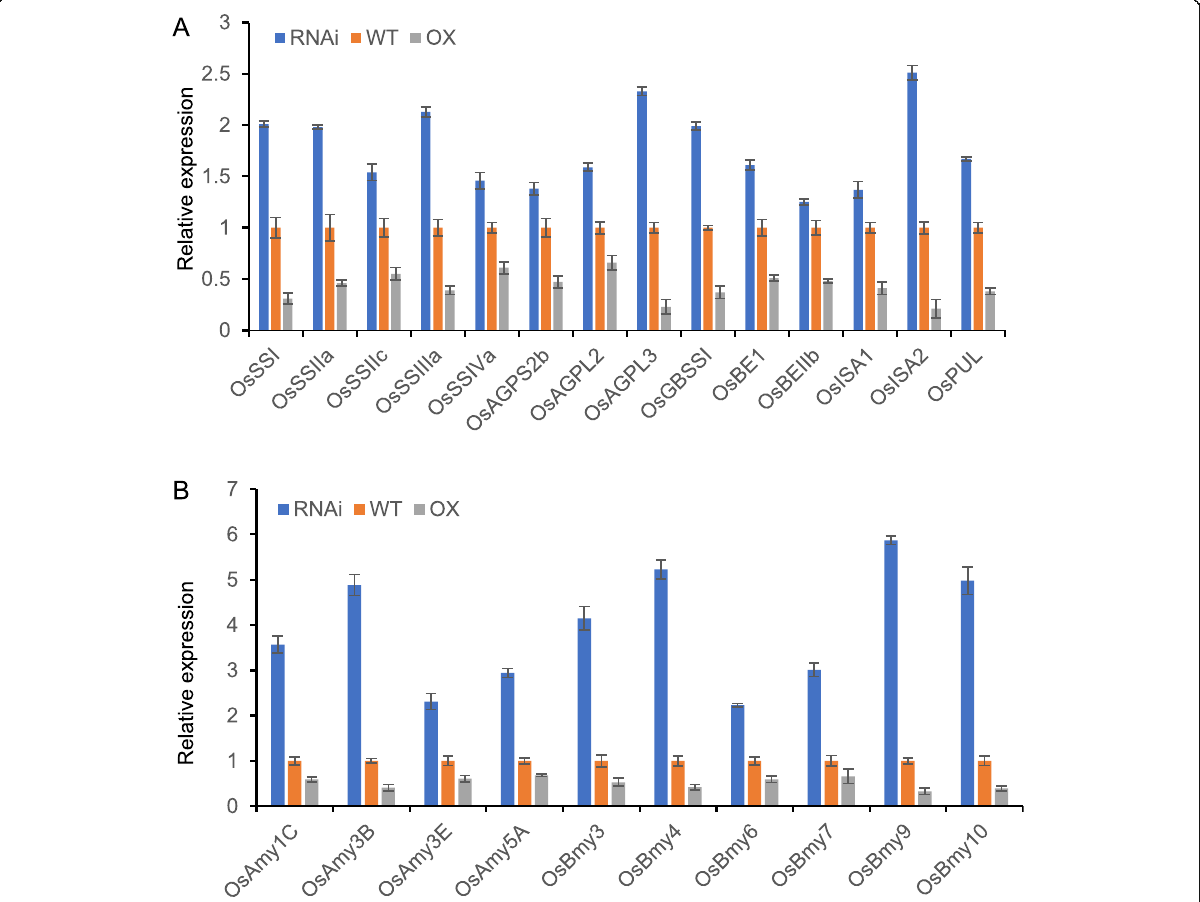
Fig. 3 Expression level of genes associated with starch metabolism in WT and SDG711 transgenic seeds at 3 DAP. Real-time PCR detection of transcript levels of starch synthase genes ( a ) and amylase genes ( b ) in WT and SDG711 transgenic seeds at 3 DAP. RNAi indicates lines of SDG711 RNAi transgenic plants and OX indicates lines of SDG711 overexpression transgenic plants. Each qRT-PCR assay was repeated three times. Values are mean ± SD. Values are shown relative to the ACTIN transcript